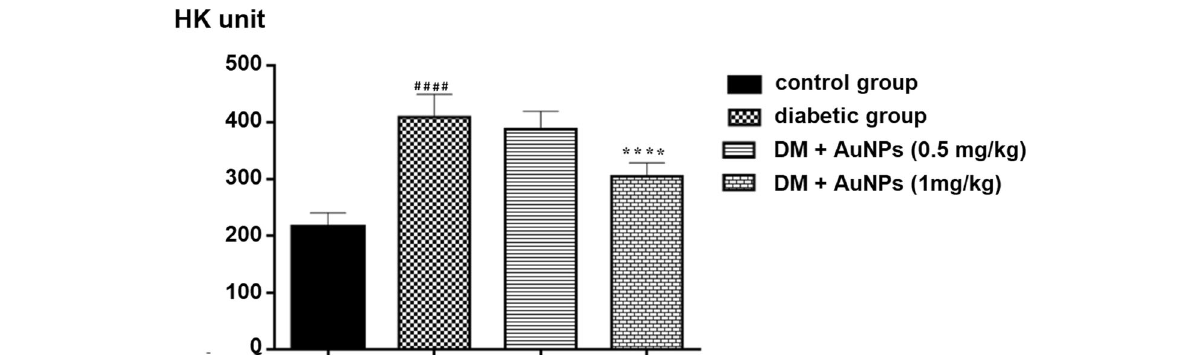
Fig. 9 Effect of AuNPs on PAB level experimental groups of rats after 21 days treatment. Data are reported to mean ± SD of 5rats in each group. *, **,***,and****represent statistically significant differences from Diabetic group at p < 0.05, 0.01,0.001 and 0.0001, respectively. #, ##, ###, and ####represents statistically significant difference from control group at p < 0.05, 0.01,0.001 and 0.0001,